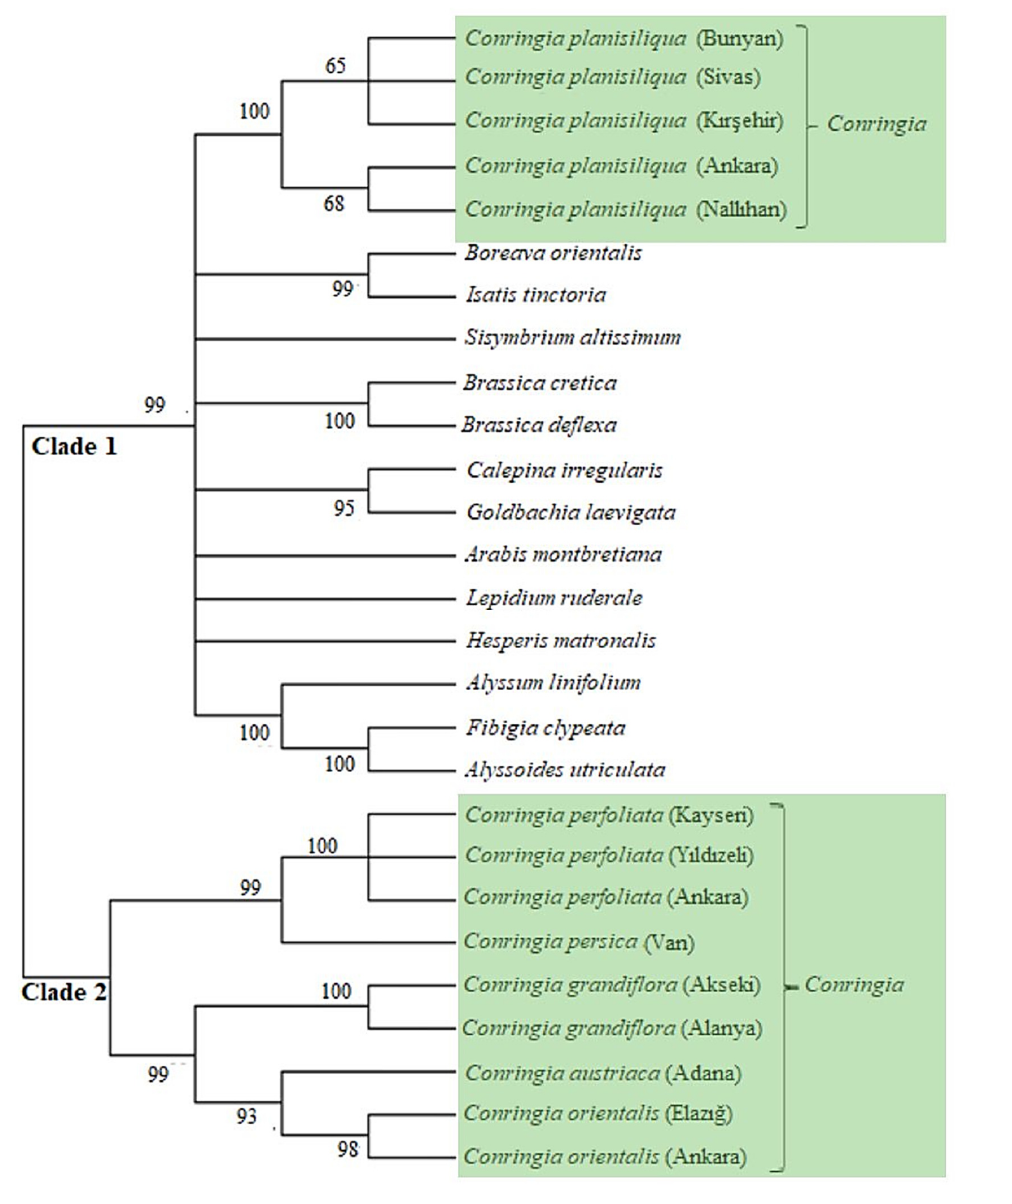
Figure 3. The Neighbour joining tree generated using nrITS sequences Conringia genus and other Brassicaceae species sequences retrieved form NCBI (Bootstrap values greater than 50% are given above